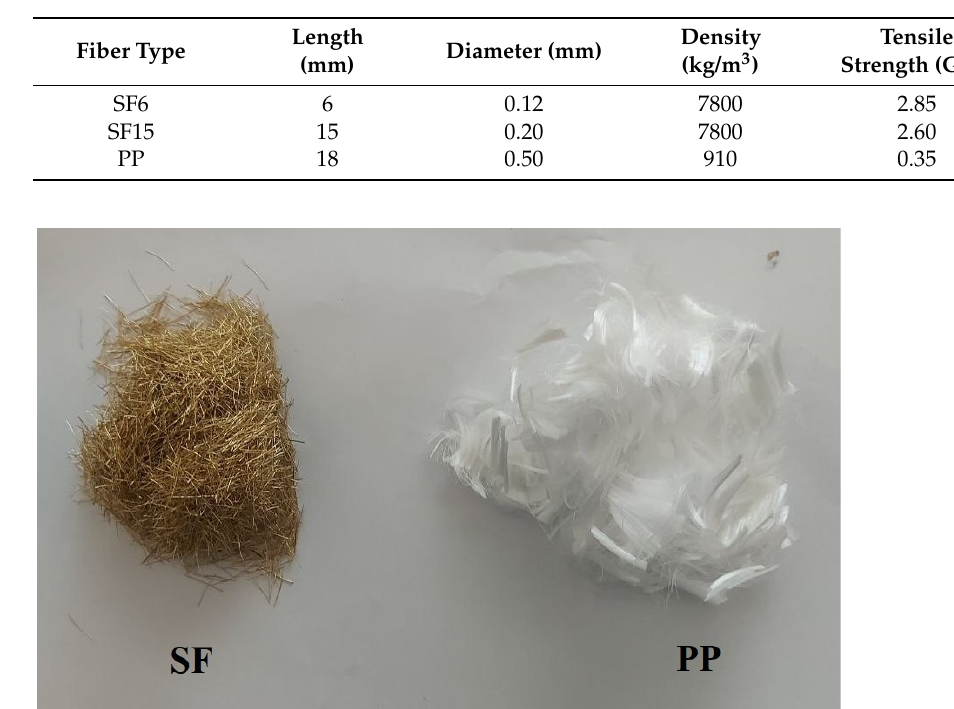
Figure 1. Visual appearance of the used micro-steel fibers (SF) and polypropylene fibers (PP). Table 1. Fiber contents of the six HPC mixtures.